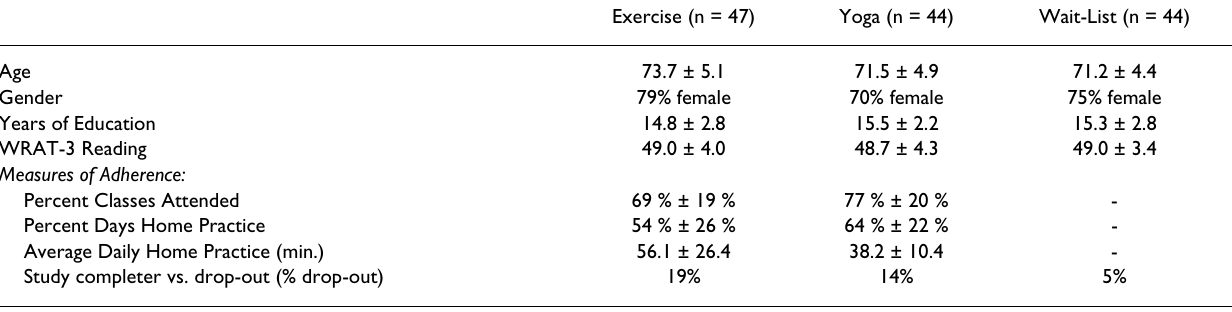
Table 1: Subject demographics and